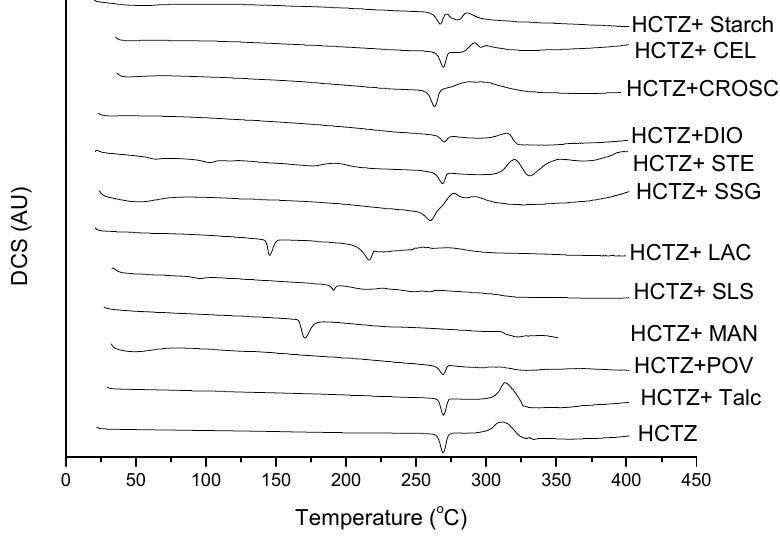
Figure 5. DSC curves of binary mixtures of HCTZ with each excipient (1:1), under nitrogen atmosphere and a heating rate of 10 °C·min − 1